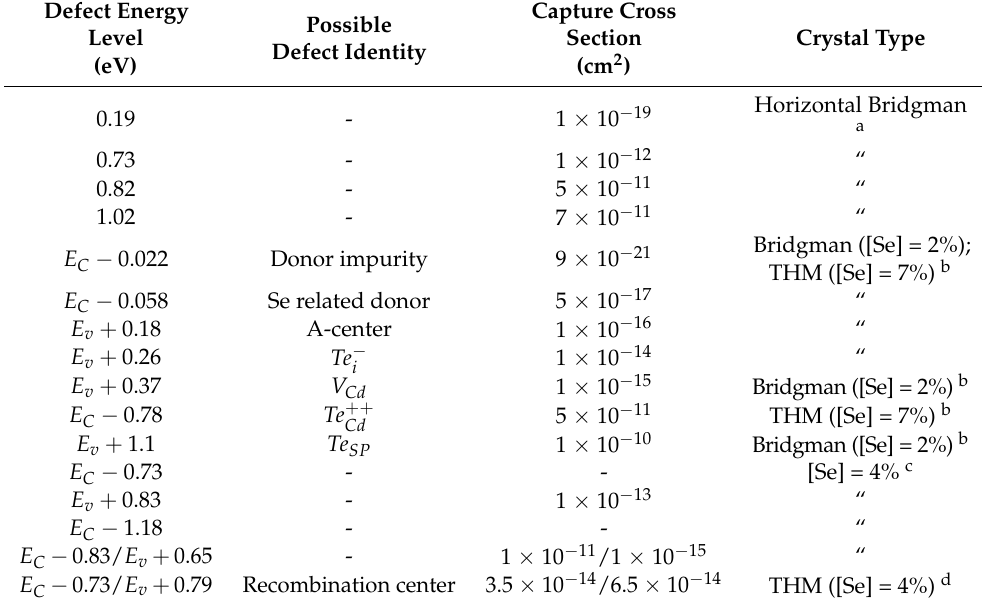
Table 2. Intrinsic defects observed in CZTS single crystals, and the related parameters reported by various groups. E C and E V represents the conduction and valence band edge, respectively. The concentration of Zn in all the CZTS samples is